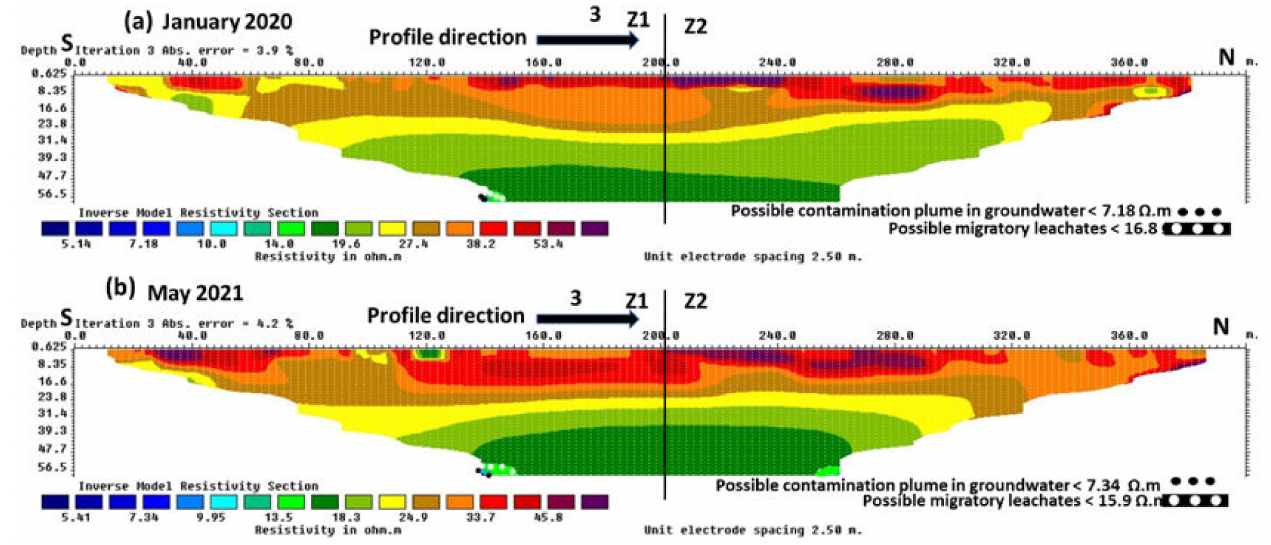
Figure 5. Electrical resistivity model of profile 3 in 2020 ( a ) and 2021 ( b ).